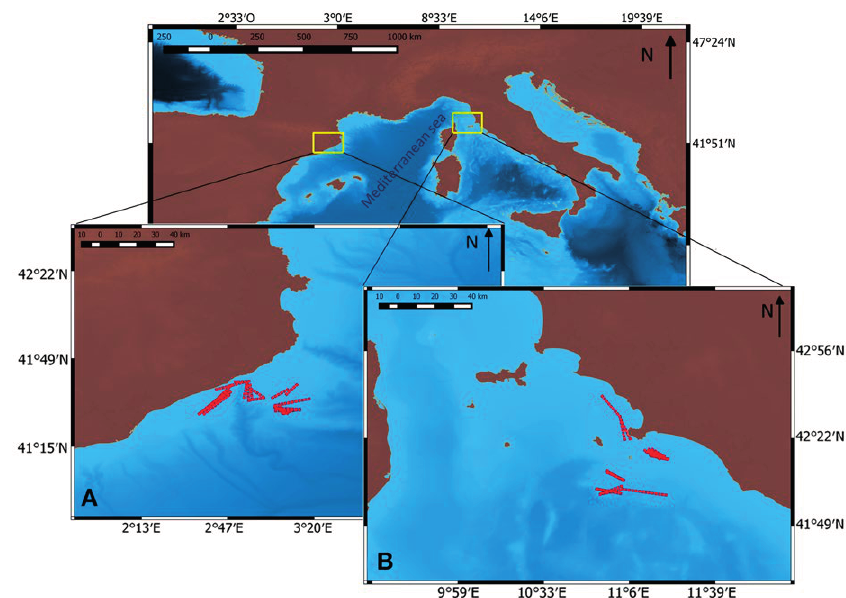
Fig. 1. – Study areas: A, Catalan coast; and B, Ligurian and northern Tyrrhenian seas. Red lines indicate hauls in the selected fishing